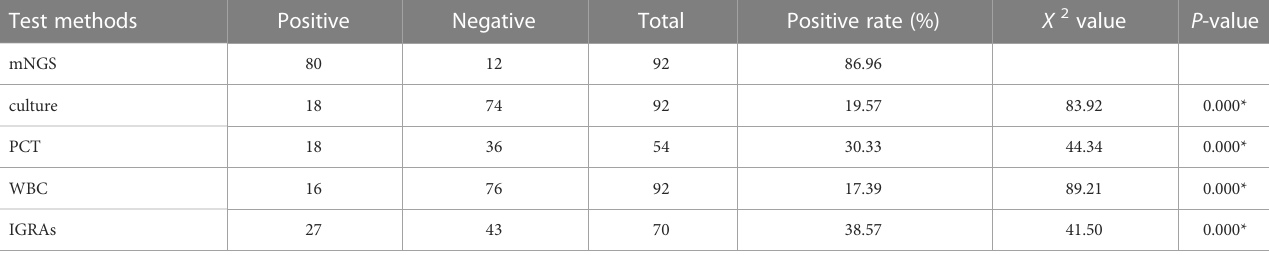
TABLE 2 Comparison of positive rate between mNGS and traditional detection